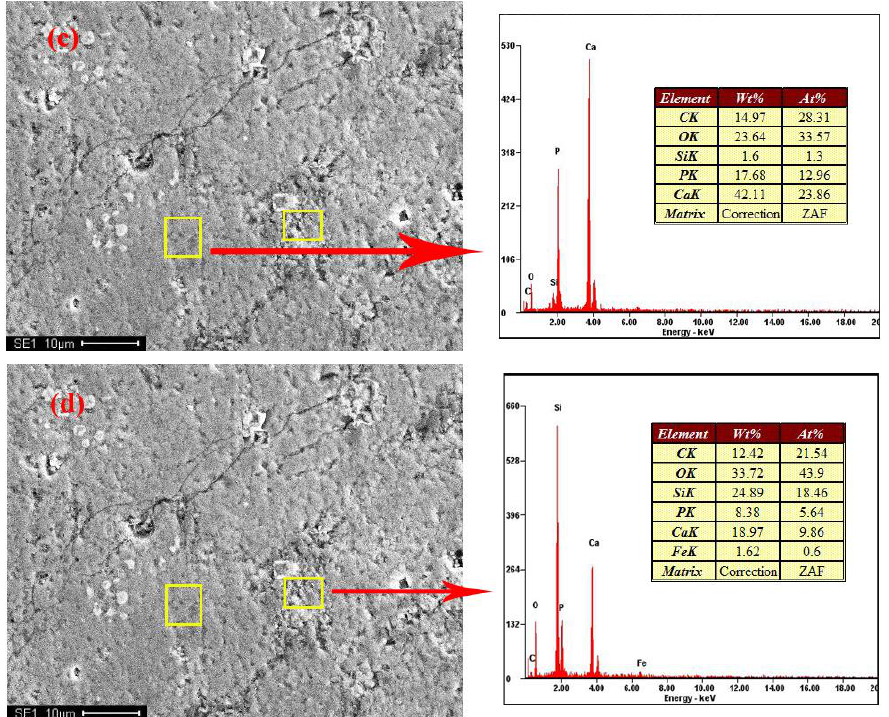
Figure 3. SEM-EDX results of samples. ( a , b ) no.1; ( c , d ) no.4.